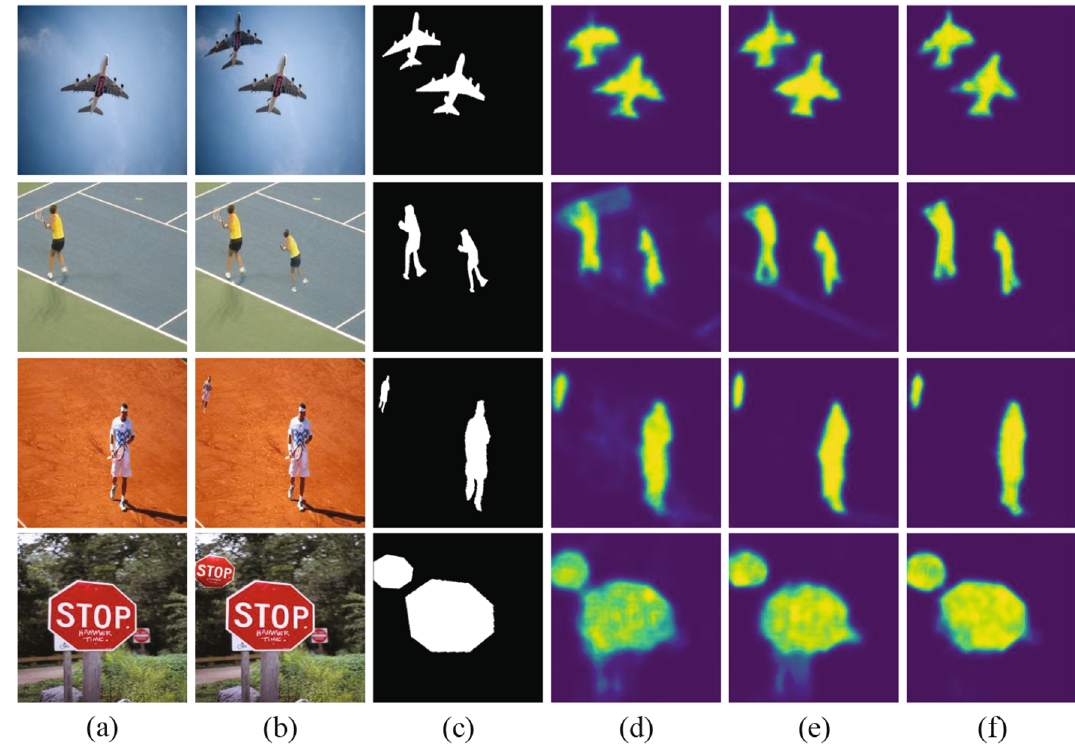
Figure 4. Detection results of the SD-Net on six copy-move forgery images in USCISI 5 datasets: ( a ) original images, ( b ) forgery images, ( c ) ground-truth tampered regions, ( d ) detection results of Base-Refine, ( e ) detection results of Base-Segment, and ( f ) detection results of the